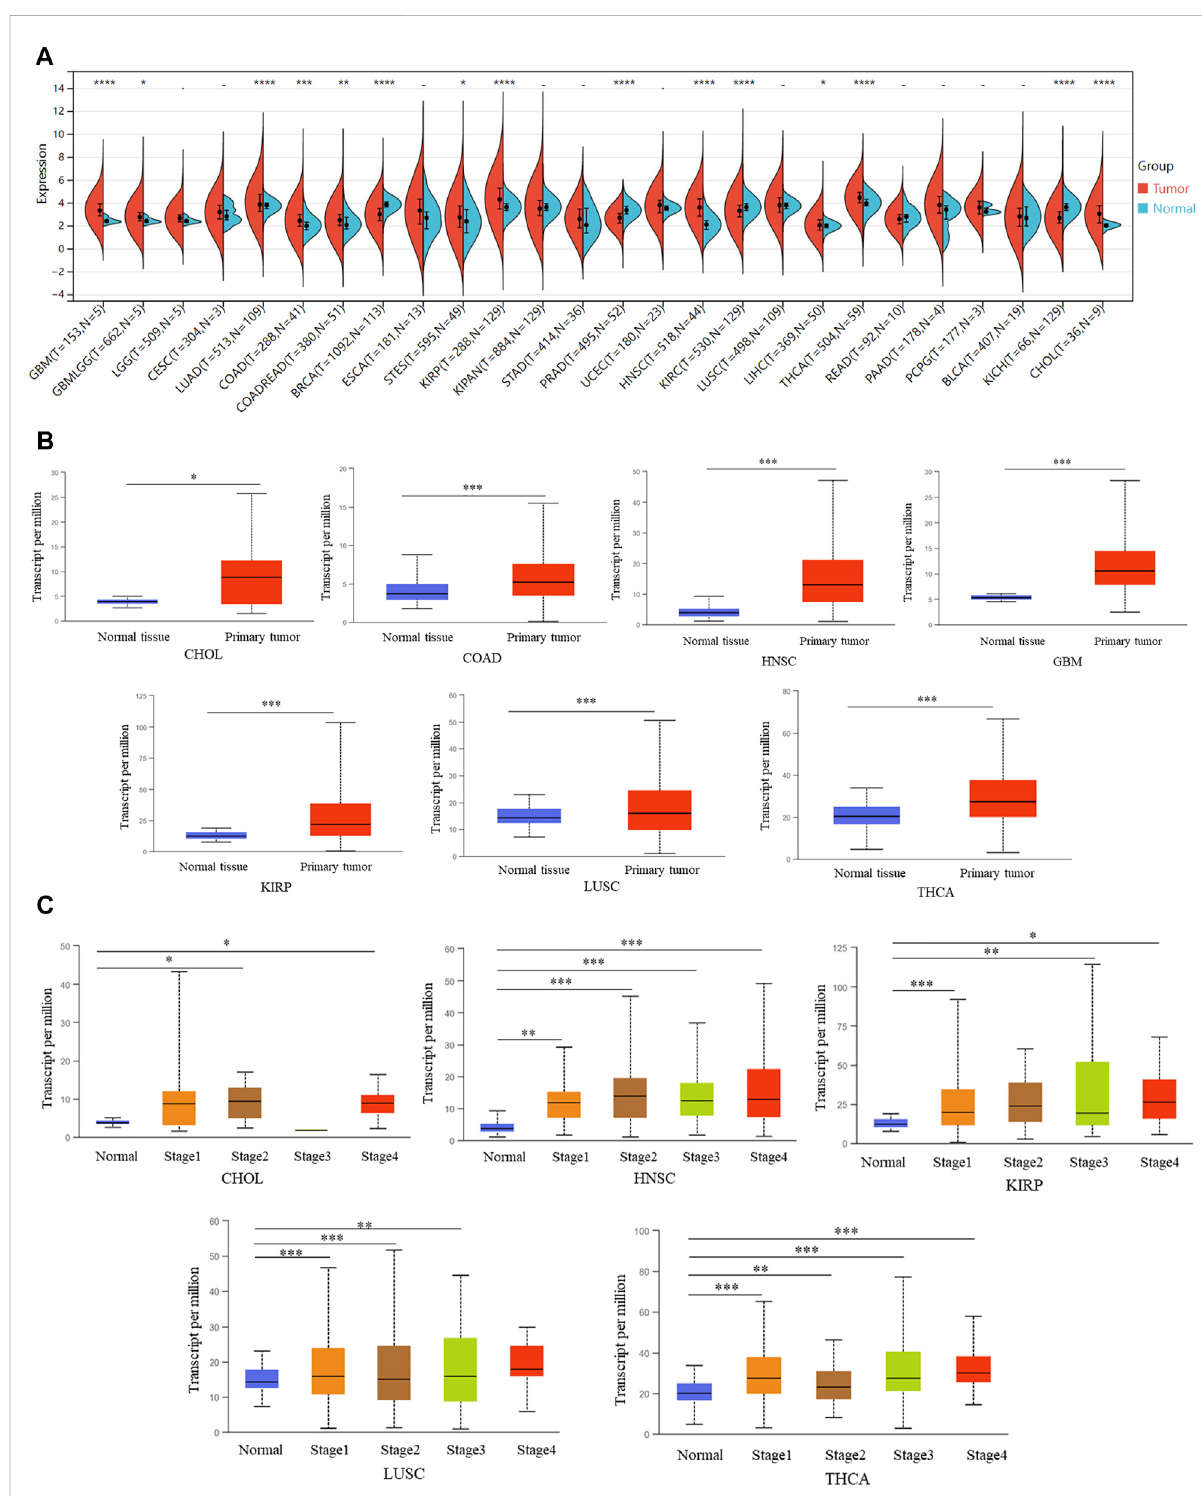
FIGURE 2 The association of the aberrant overexpression of DCBLD2 with tumor stages. (A) Differential DCBLD2 expression levels (log2 x + 1) between tumor and adjacent normal tissues as adopted from TCGA data. (B) Differential DCBLD2 expression for the type of CHOL, COAD, GBM, HNSC, KIRP, LUSC, and THCAas adoptedfrom TCGAdata. * p < 0.05, ** p < 0.01, ** p < 0.001. (C) For thetypeofCHOL,HNSC,KIRP, LUSC and THCAin theTCGA project,theboxplotdataofdifferential DCBLD2 expression levels(log2x+1)betweenpathologicalstages (stagesI,II,III,andIV)weresupplied. * p < 0.05, ** p < 0.01, ** p <